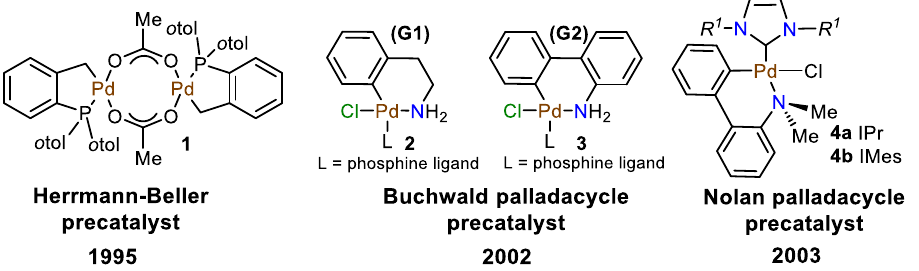
Figure 1. Herrmann–Beller precatalyst ( 1 ) and Buchwald precatalyst generations G1 ( 2a ), G2 ( 2b ), Solvias precatalyst ( 3 ) and Nolan precatalyst ( 4 ).